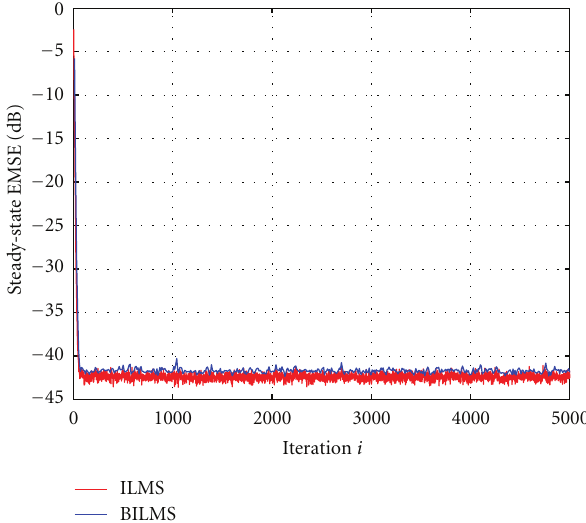
Figure 11: Global excess mean-square deviation (EMSE) curve for incremental LMS and block incremental LMS.